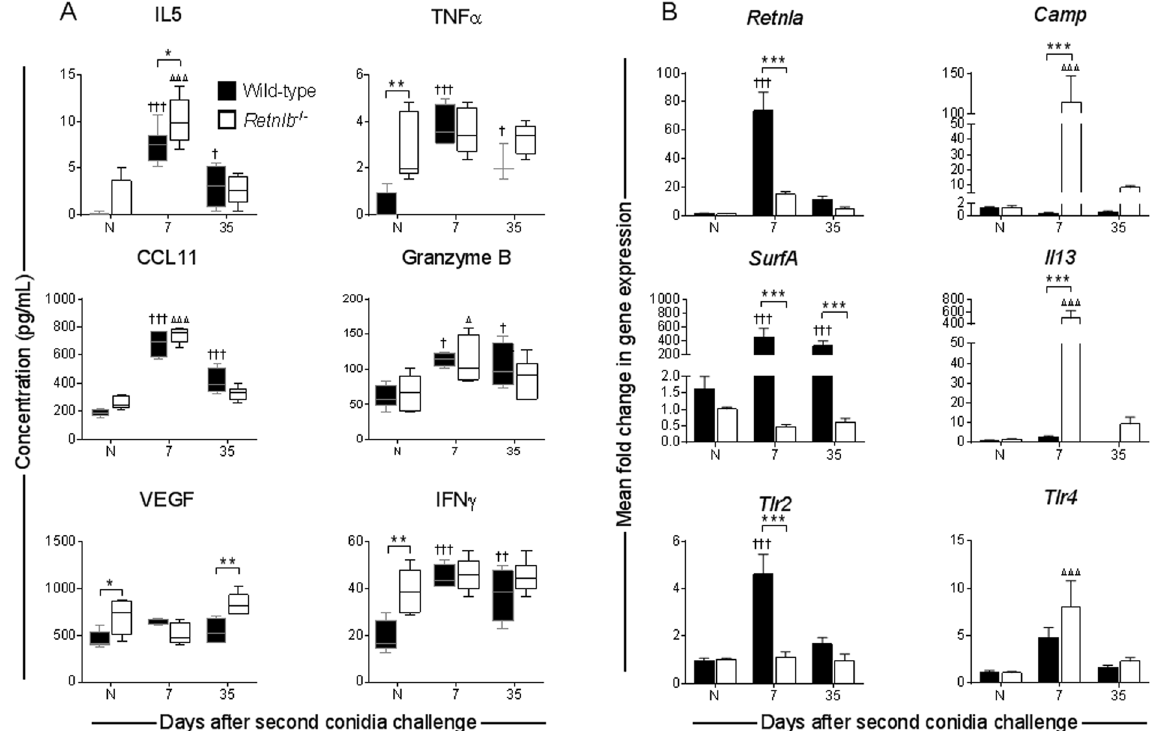
Figure 7. Biomarkers of inflammation increased in response to allergen challenge. Cytokines in the bronchoalveolar lavage fluid were measured in each genotype and found to be elevated in mice subjected to the fungal asthma model. Notably, Retnlb deficient mice had elevated TNF α , VEGF, and IFN γ at steady state compared to WT controls ( A ). Wild-type mice had rapid increase in cytokines at early time points with gradual depletion over time whereas Retnlb KO followed similar trends in cytokine production, albeit at slightly lower levels at early time points ( A ). Wild-type mice had markedly elevated expression of Retnla and SurfA in the lung while Retnlb null mice had markedly elevated Camp and Il13 ( B ). Expression of Tlr2 dominated at the early time point in the wild-type mice while Trl4 took precedence in the Retnlb null mice ( B ). Data shown as range from minimum to maximum where lines and dots represent the median and mean respectively ( A ) and as the mean and SD ( B ) of n = 4–7 mice/group and representative of one independent study of two. Data analysed with two-way ANOVA with Sidak’s and Dunnett’s multiple comparisons test to compare data between groups at each time point ( * ) or to naïve controls within groups († in WT and Δ in KO) respectively, where significance values p < 0.05, p < 0.01, and p < 0.001 are denoted by one, two, or three symbols respectively. N –